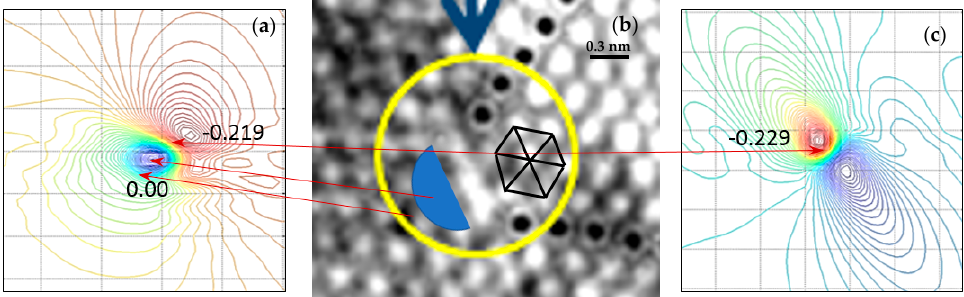
Figure 13. ( a ) Level lines of derivative ∂ u e2 / ∂ e 2 ; ( b ) dislocation area; ( c ) level lines of derivative ∂ u e3 / ∂ e 3 . The spatial scale is Å.